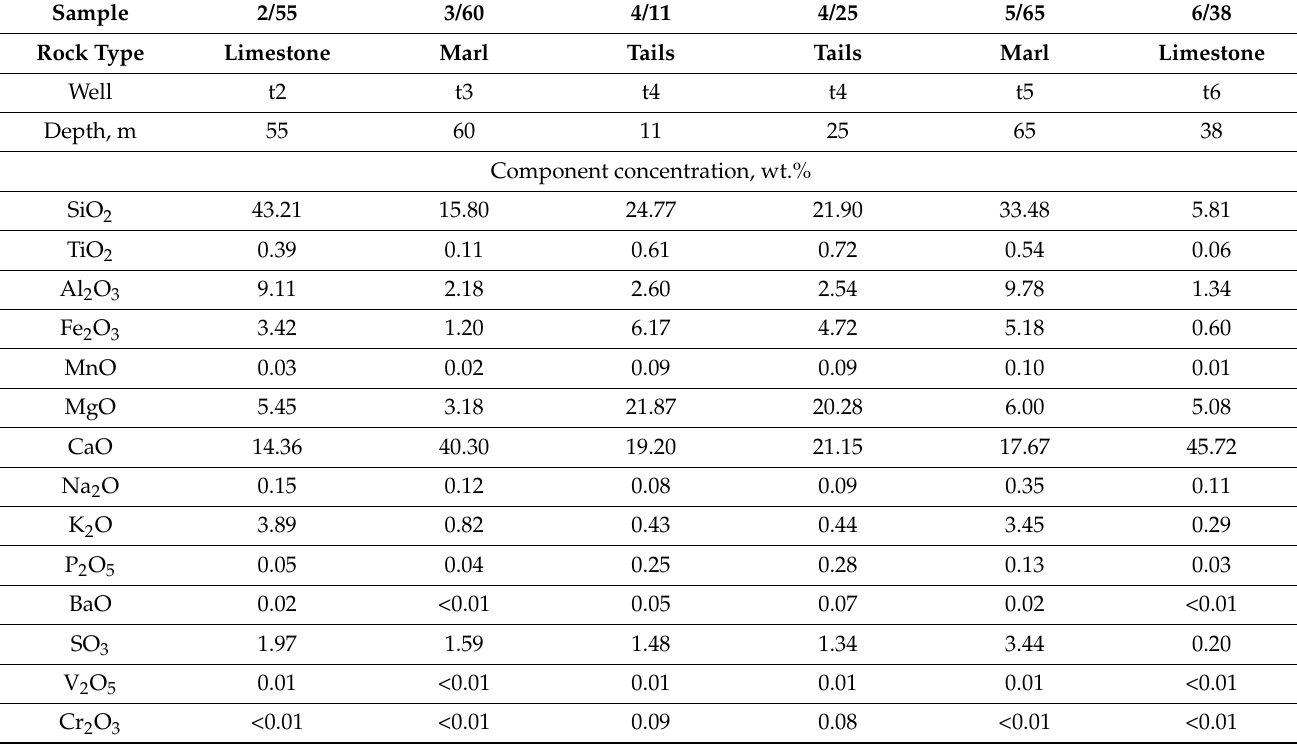
Table 2. Composition of dam rocks taken for thermodynamic modeling of the “water–rock”